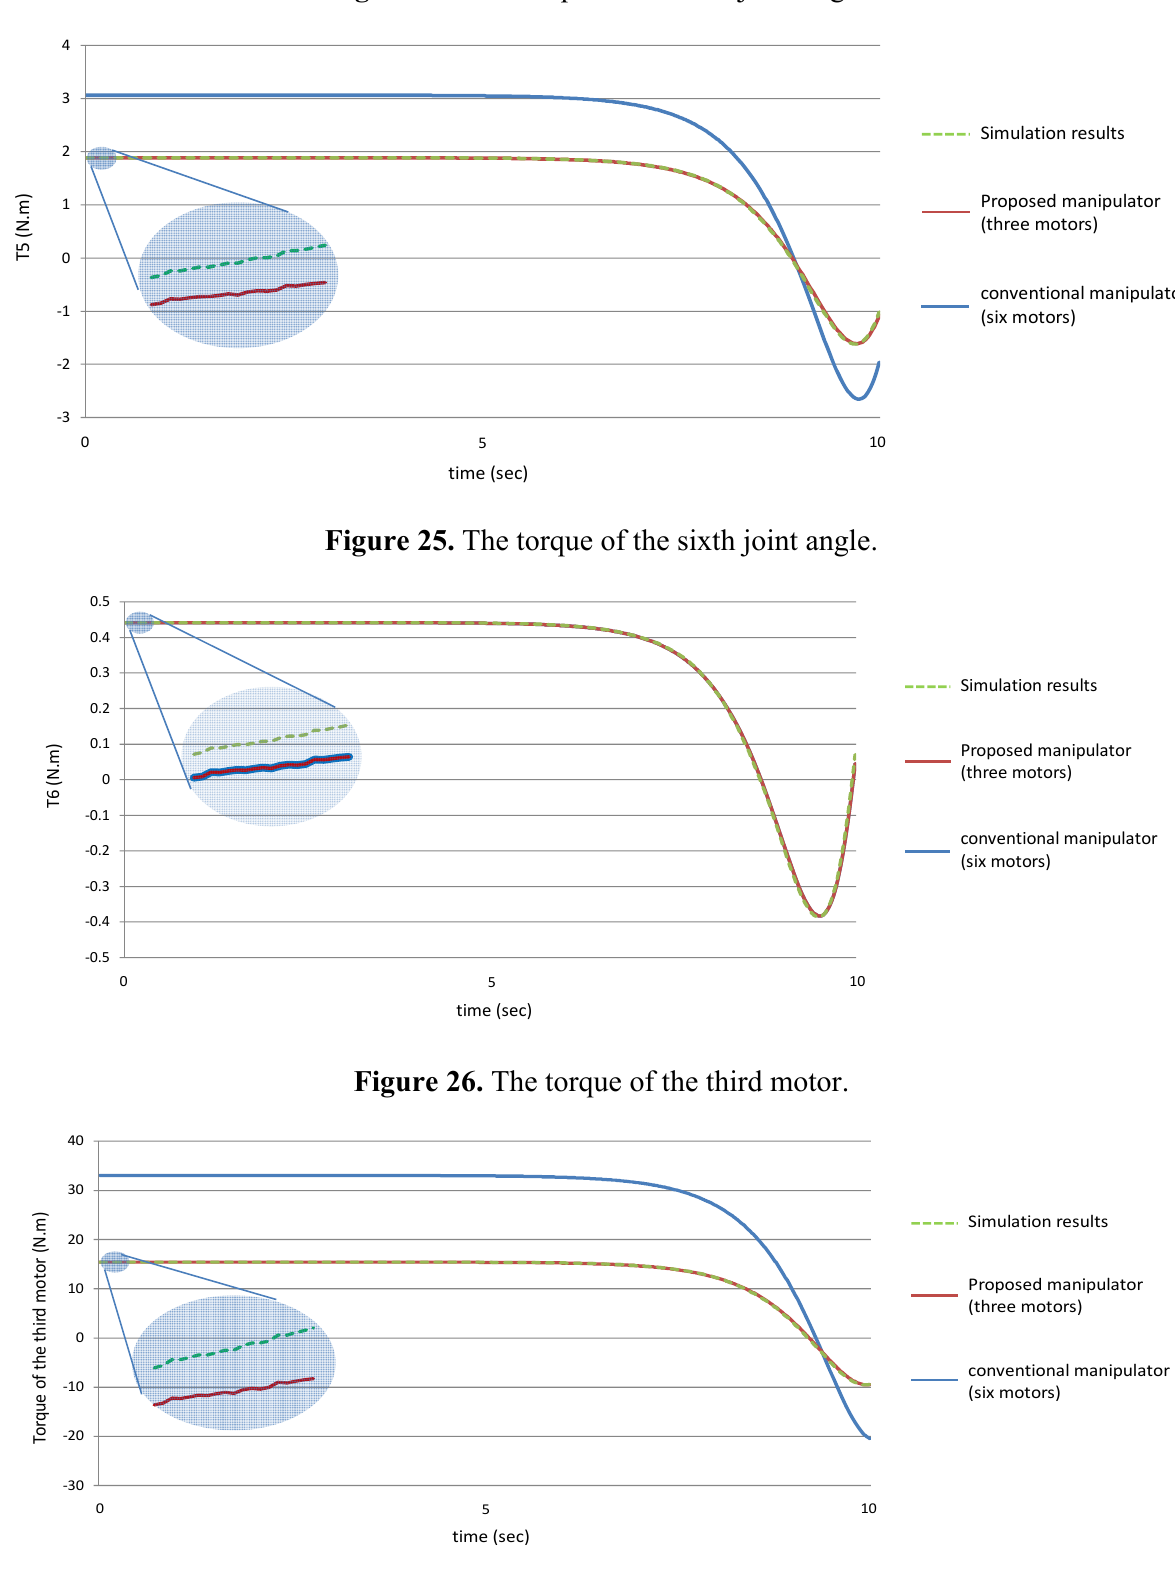
Figure 24. The torque of the fifth joint angle.